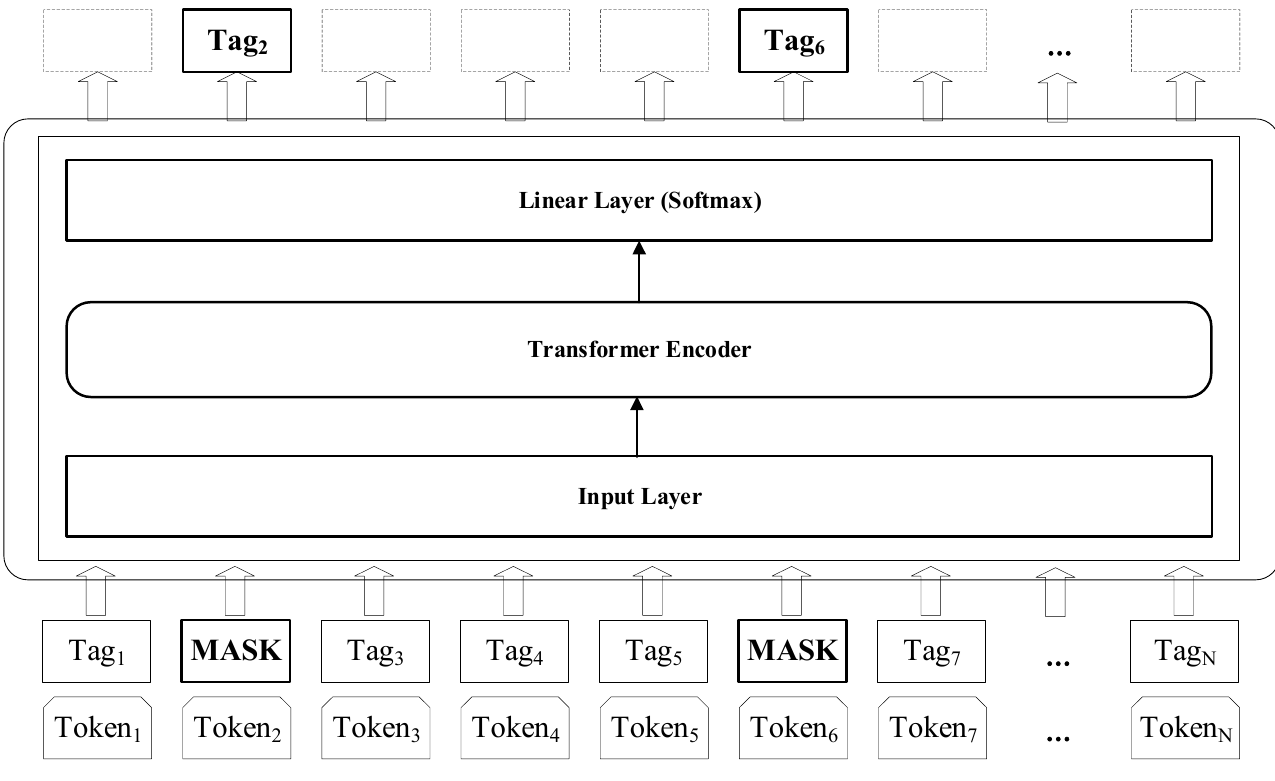
Figure 5. The structure of the